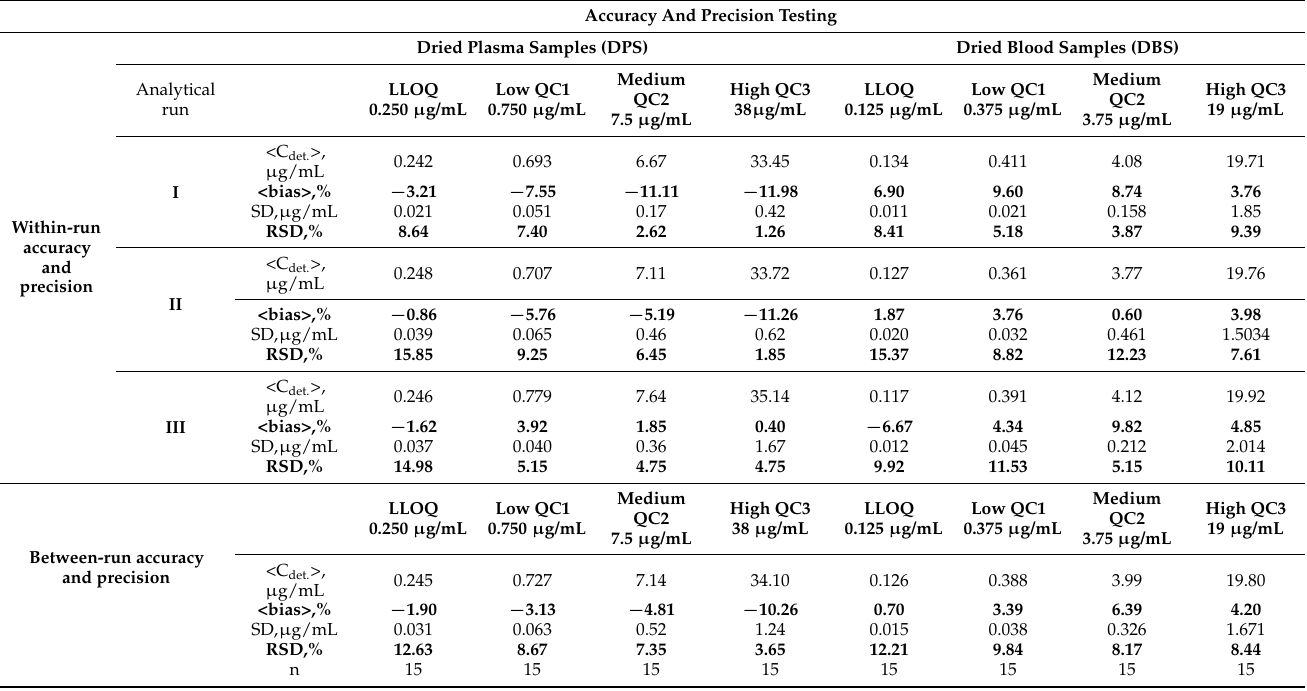
Table 3. Accuracy and precision testing for the DPS and DBS samples. Accuracy And Precision